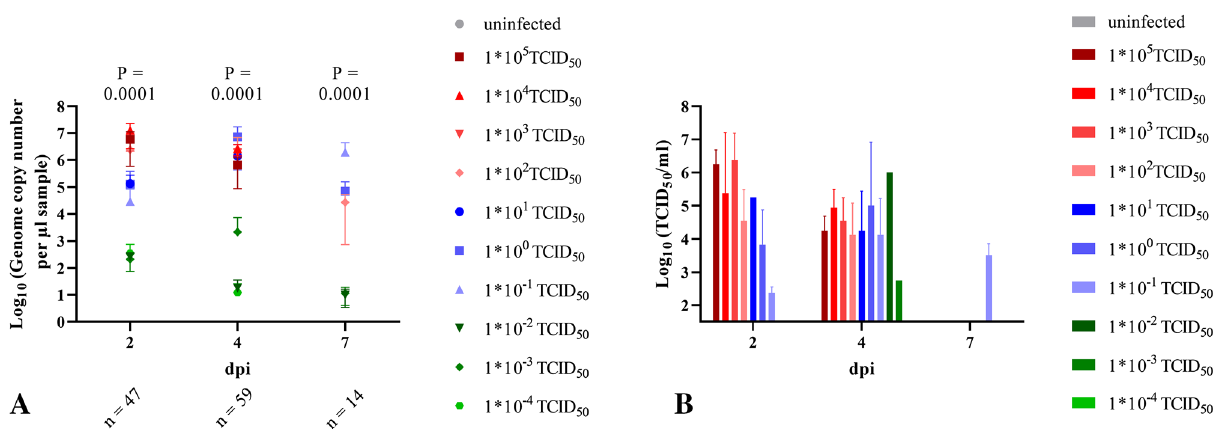
Figure 6. Viral shedding in nasal washes. ( A ) Genome copy number (Log 10 ) of SARS-CoV-2 RNA and ( B ) replication competent virus (Log 10 TCID 50 /ml) detected in the nasal wash samples of all hamsters 2, 4 and 7 dpi. All groups were analysed, negative results are not shown. Details on statistical analysis are shown in Table S1. Colors match and represent results from the same hamsters as shown before and following.